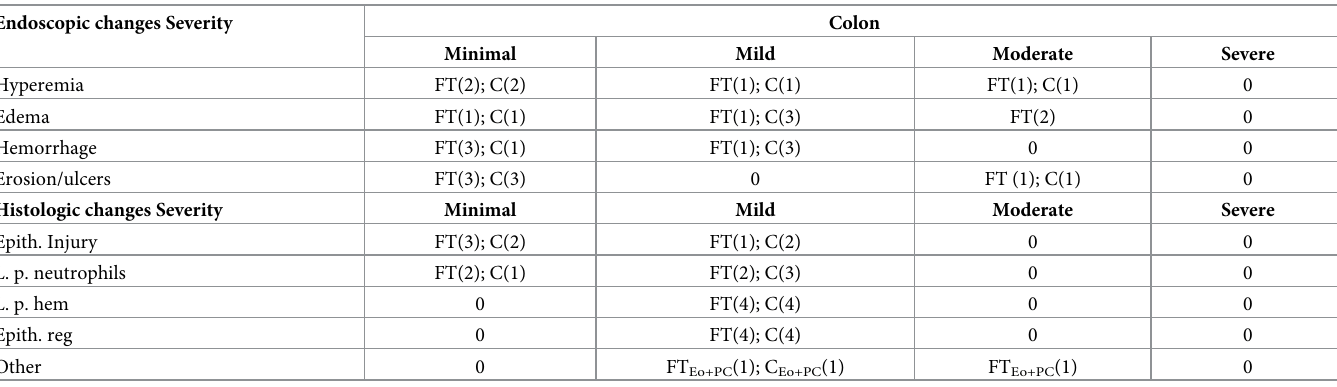
Table 2. Endoscopic and histologic changes in dogs with AHDS.